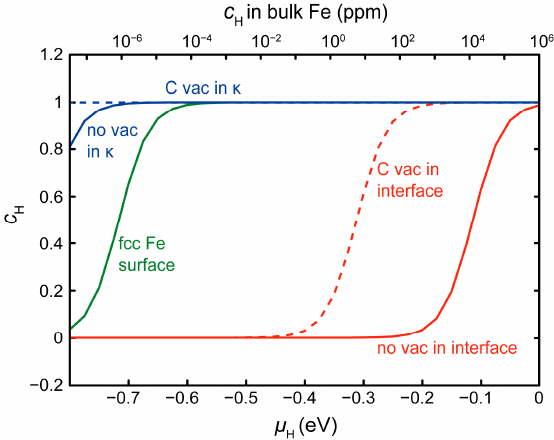
Figure 9. Equilibrium concentration of H at the C-terminated interface, free κ -carbide (C-terminated) and fcc-Fe surfaces as a function of the chemical potential of hydrogen. A perfect κ -carbide (solid lines) is compared with a κ -carbide that contains a C vacancy (dashed lines).